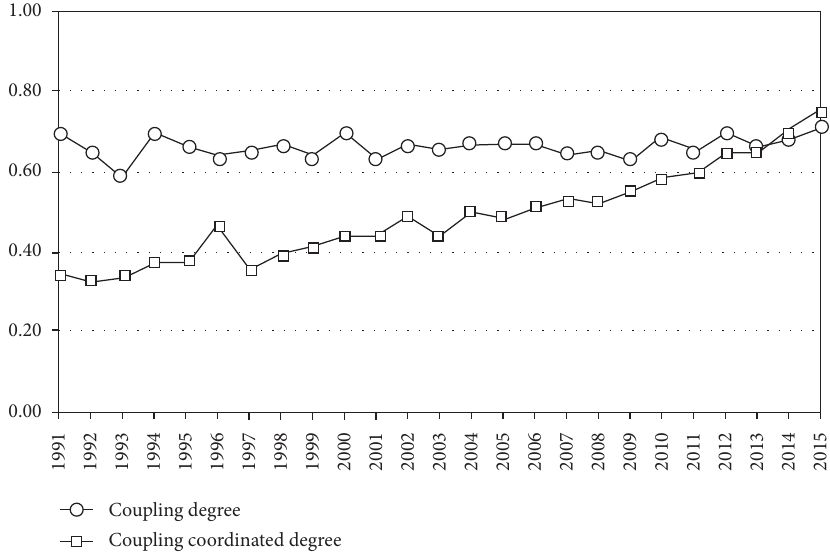
Figure 4: Time-series changes of coupling degree and coupling coordination degree of AT and TD